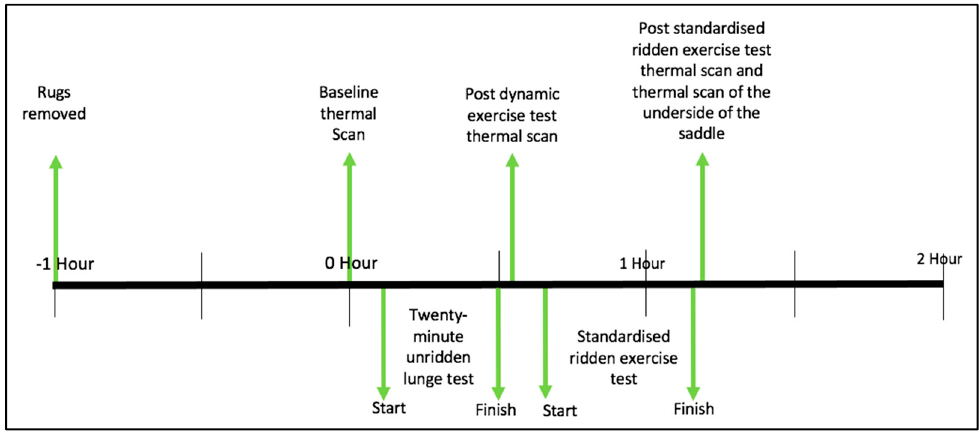
Figure 2. Illustrating the various stages of the experiment including the timepoints at which the thermal scans were taken along with the two exercise